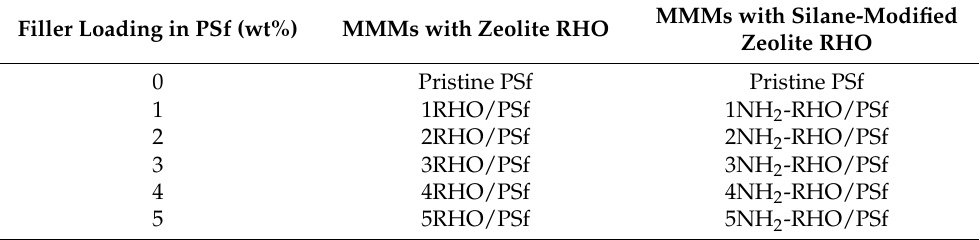
Table 1. The pristine membrane and MMMs fabricated in current study. Filler Loading in PSf